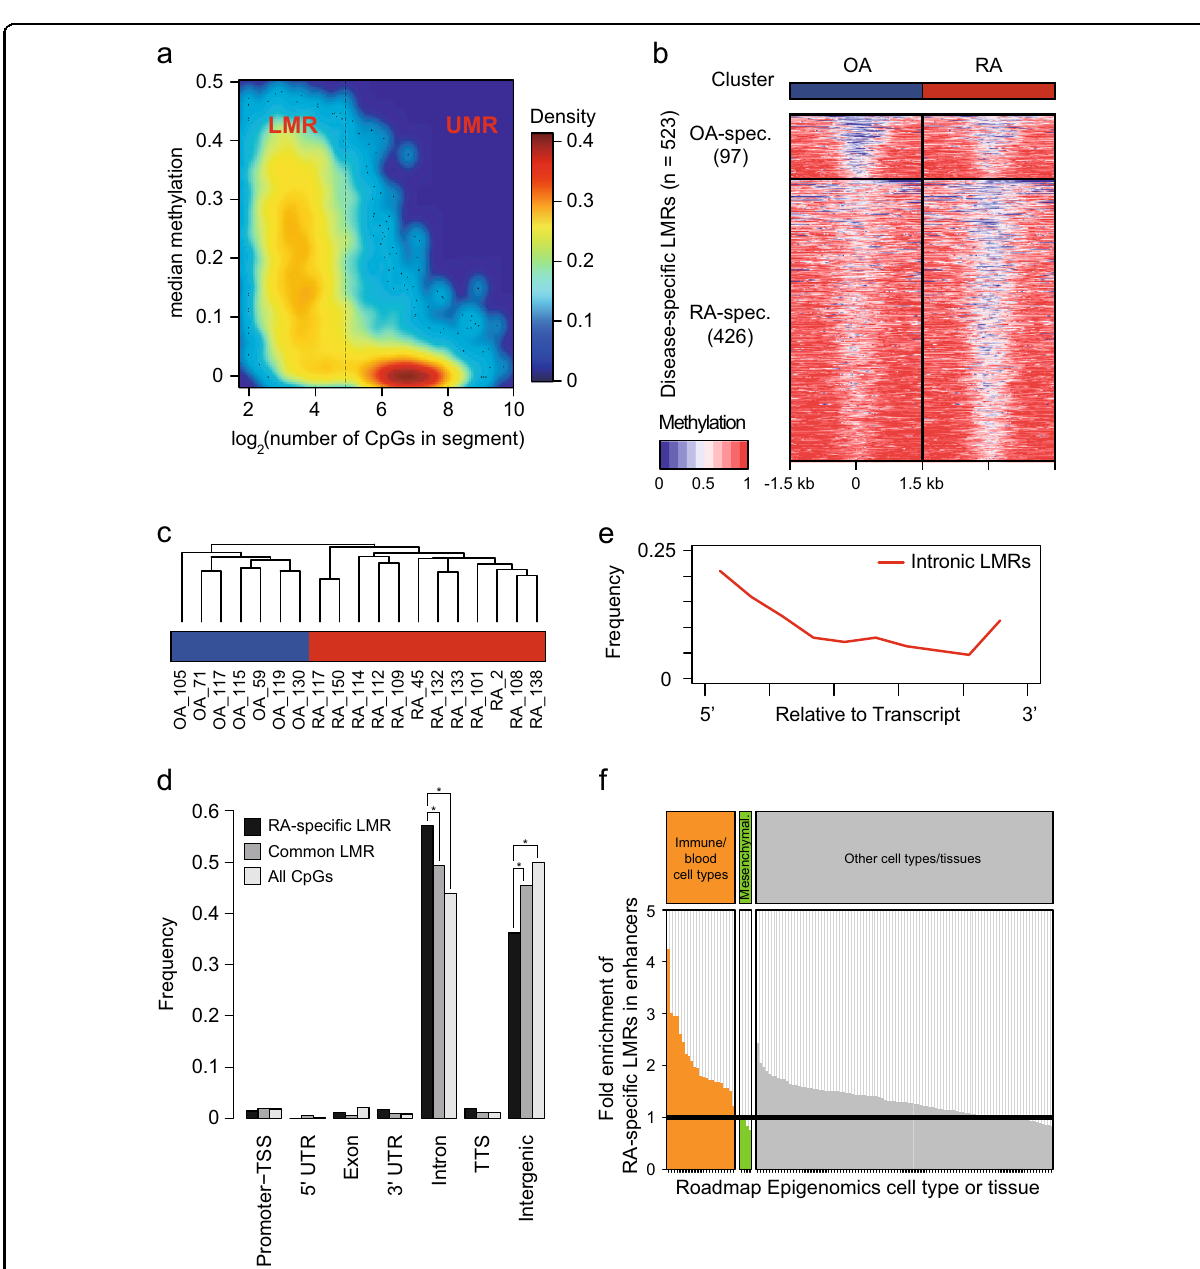
Fig. 2 Identi fi cation of focal methylated regions speci fi c to RA or OA. a A colored scatterplot showing hypomethylated regions after excluding PMDs. The middle line divides the regions into unmethylated regions (UMRs, left) and low-methylated regions (LMRs, right). Densities of individual CpGs are estimated using kernel functions and are colored-scaled. b A heatmap with clusters of LMRs speci fi c to each disease. Ticks represent distance from the center of given LMRs. c A hierarchical clustering of samples based on the Jaccard indexes calculated from LMRs. OA is blue and RA is red. d The distribution of intragenic LMRs. * P < 0.01, Pearson ’ s chi-squared test. e The distribution of intronic RA-speci fi c LMRs relative to transcripts. f A bar plot with the ratio of RA-speci fi c LMRs to OA-speci fi c LMRs overlapping enhancers in blood/immune cell types (left), mesenchymal cell types (middle), and other cell types (right). Enhancers were inferred from the chromatin landscape of NIH ’ s Roadmap Epigenomics project